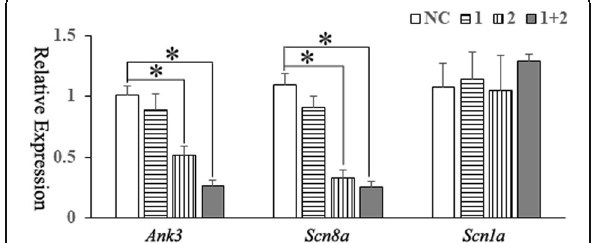
Fig. 1 mRNA levels of Ank3 , Scn8a and Scn1a after siRNA interference. The relative Ank3 mRNA levels decreased significantly after siRNA interference in group 2 and group 1 + 2. The expression of Scn8a decreased 69.9 ± 8.4% in group2 ( P < 0.05) and 77.3 ± 4.1% in group1 + 2( P < 0.05). The relative mRNA level of Scn1a of HT22 cells after the interference of siRNA of Ank3 remained relative